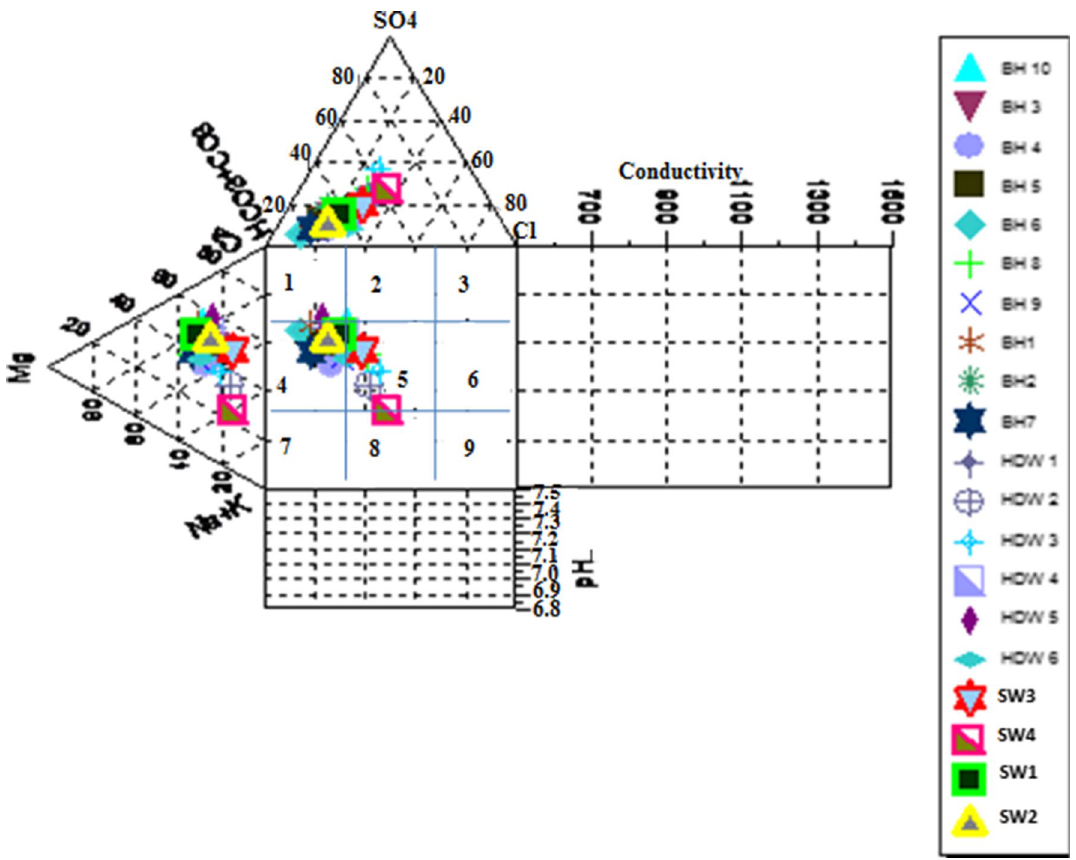
Fig. 9 Durov diagram showing (dissolution as) the secondary geochemical